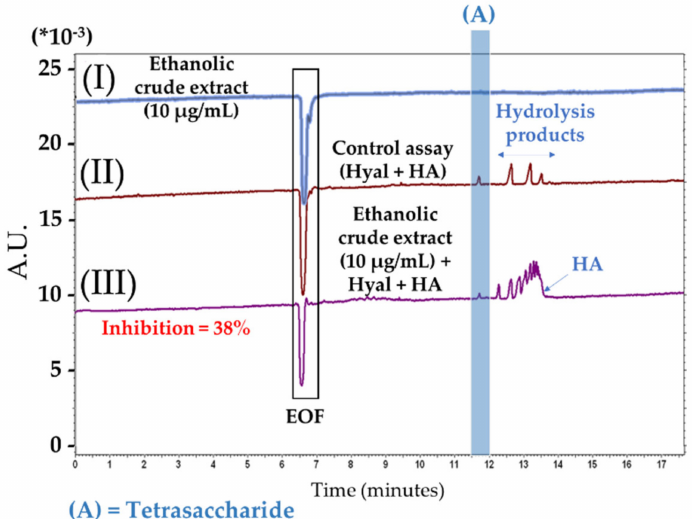
Figure 2. Examples of electropherograms (I − III) showing the inhibitory effect on hyaluronidase of ethanolic crude extract of AP of P. cuspidatum from Savoie Mont Blanc. (I) AP extract at 10 µ g/mL; (II) Enzymatic assay in absence of AP extract and (III) Enzymatic assay in presence of AP extract at 10 µ g/mL. Hyal: hyaluronidase and HA: hyaluronic acid. Reaction mixture in IB of control: 200 µ g/mL Hyal and 800 µ g/mL of HA. Modulation of hyaluronidase activity experimental